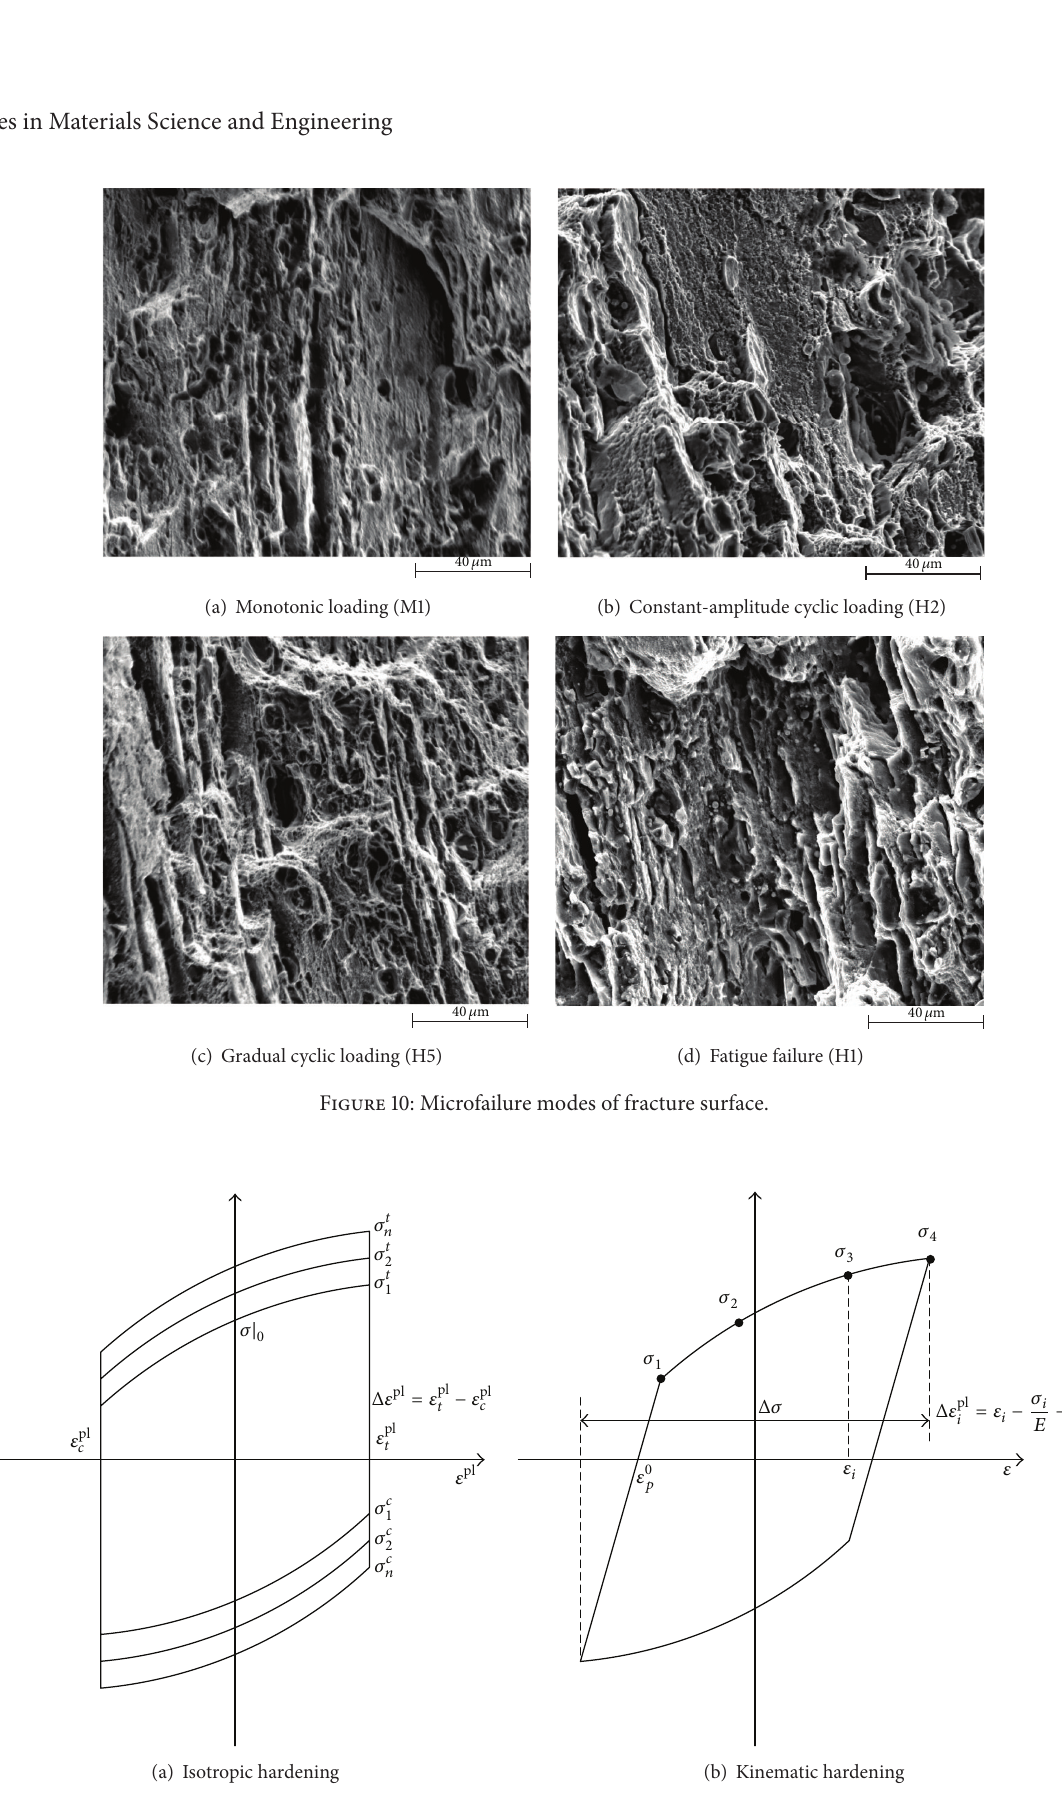
Figure 11: Schematic diagram of the isotropic hardening and kinematic